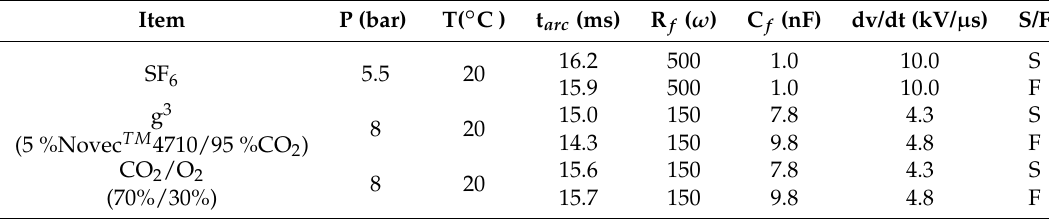
Table 5. Test conditions of circuit breaker with arc-quenching